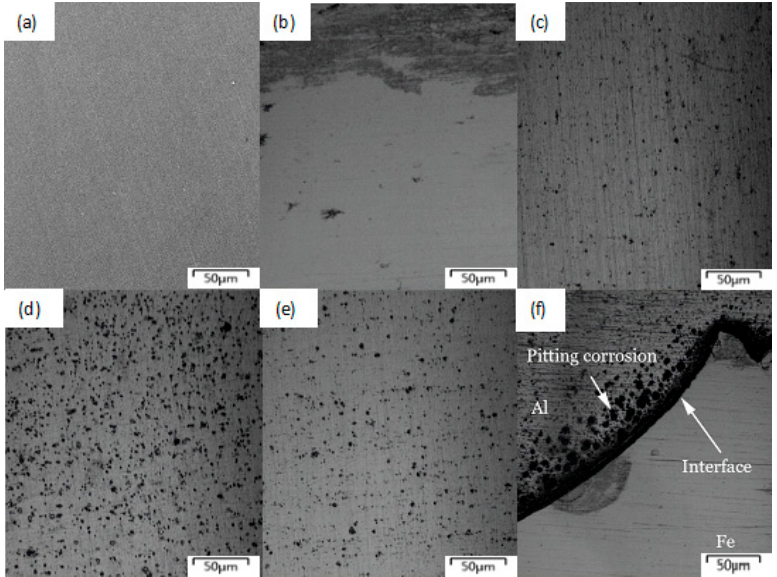
Figure 9. The microscopic corrosion morphology of the transverse section of 6082 aluminum alloy on different zones in keyhole-free FSSW joints before and after immersion for 96 h: ( a ) before immersion; ( b ) WNZ (Weld Nugget Zone); ( c ) TMAZ (Thermo-mechanically Affected Zone); ( d ) HAZ (Heat-affected Zone); ( e ) BM (Base Metal); ( f ) the interface of aluminum and steel.